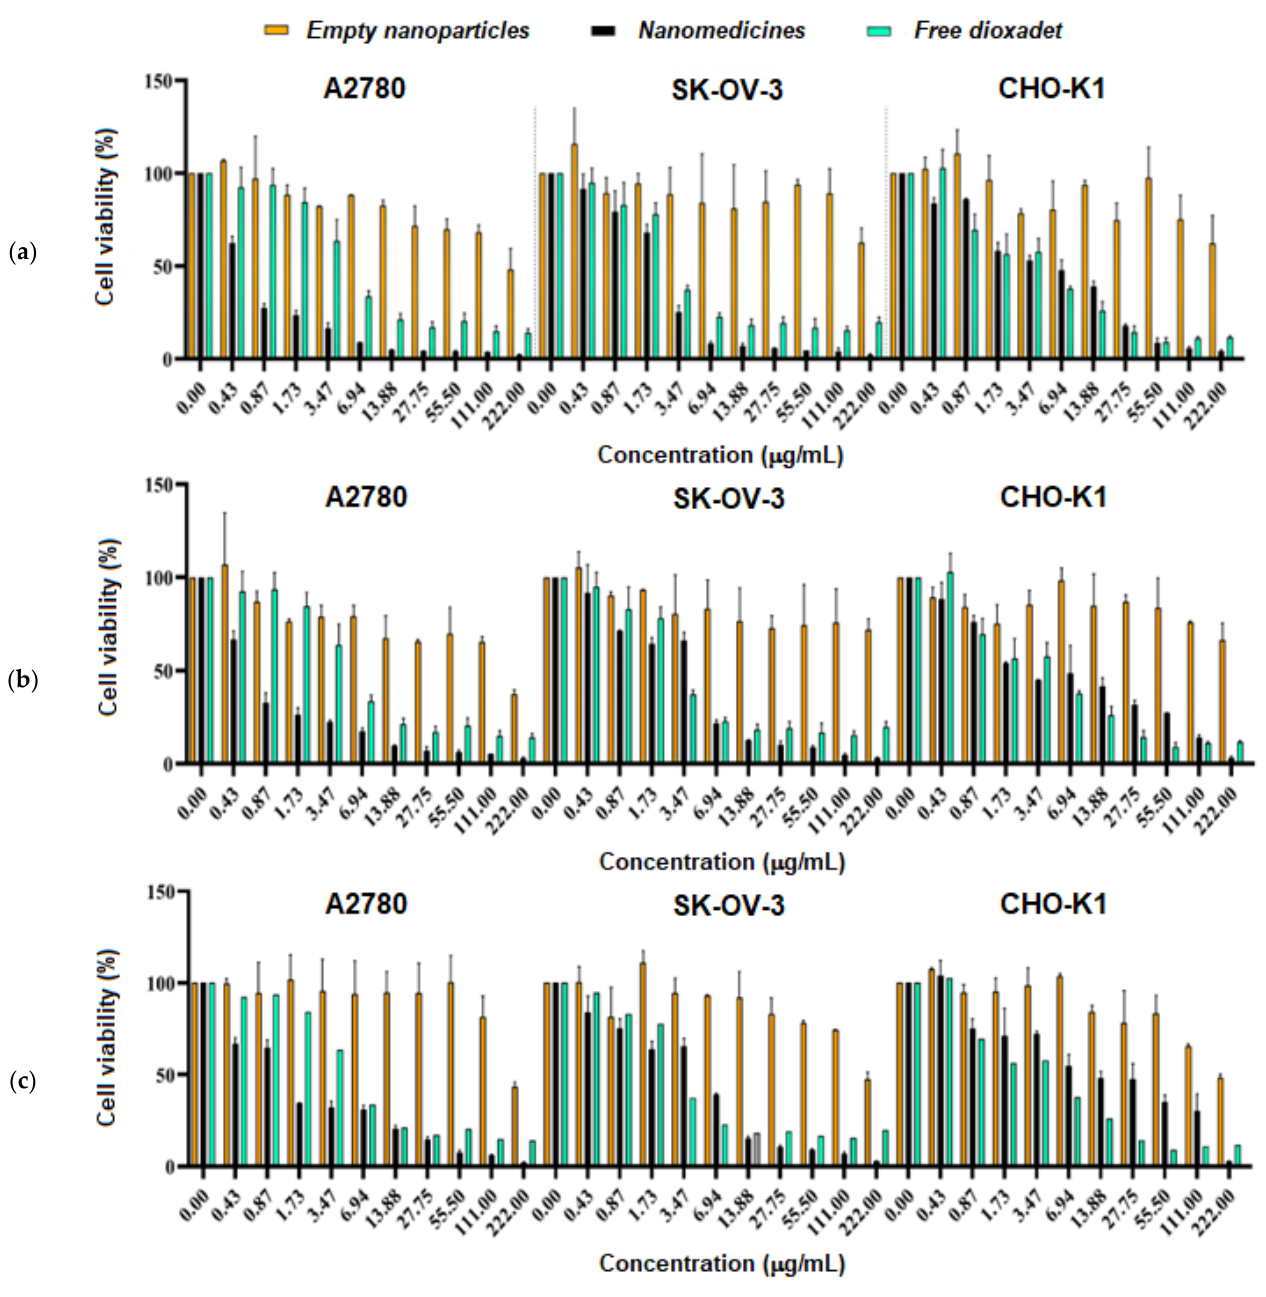
Figure 12. Cell viability of different cell lines in the presence of empty nanoparticles, nanomedicines, and free dioxadet. Empty nanoparticles and nanomedicines were obtained using the following polymers as a base: mPEG- b -PCL with Mw = 29,200 ( a ), mPEG-b-PLA with Mw = 36,400 ( b ), and mPEG-b-PLA with Mw = 10,000 ( c ). Table 5. IC 50 values determined for free dioxadet and its nanomedicines based on mPEG- b -PLA and mPEG- b -PCL for three different cell lines.